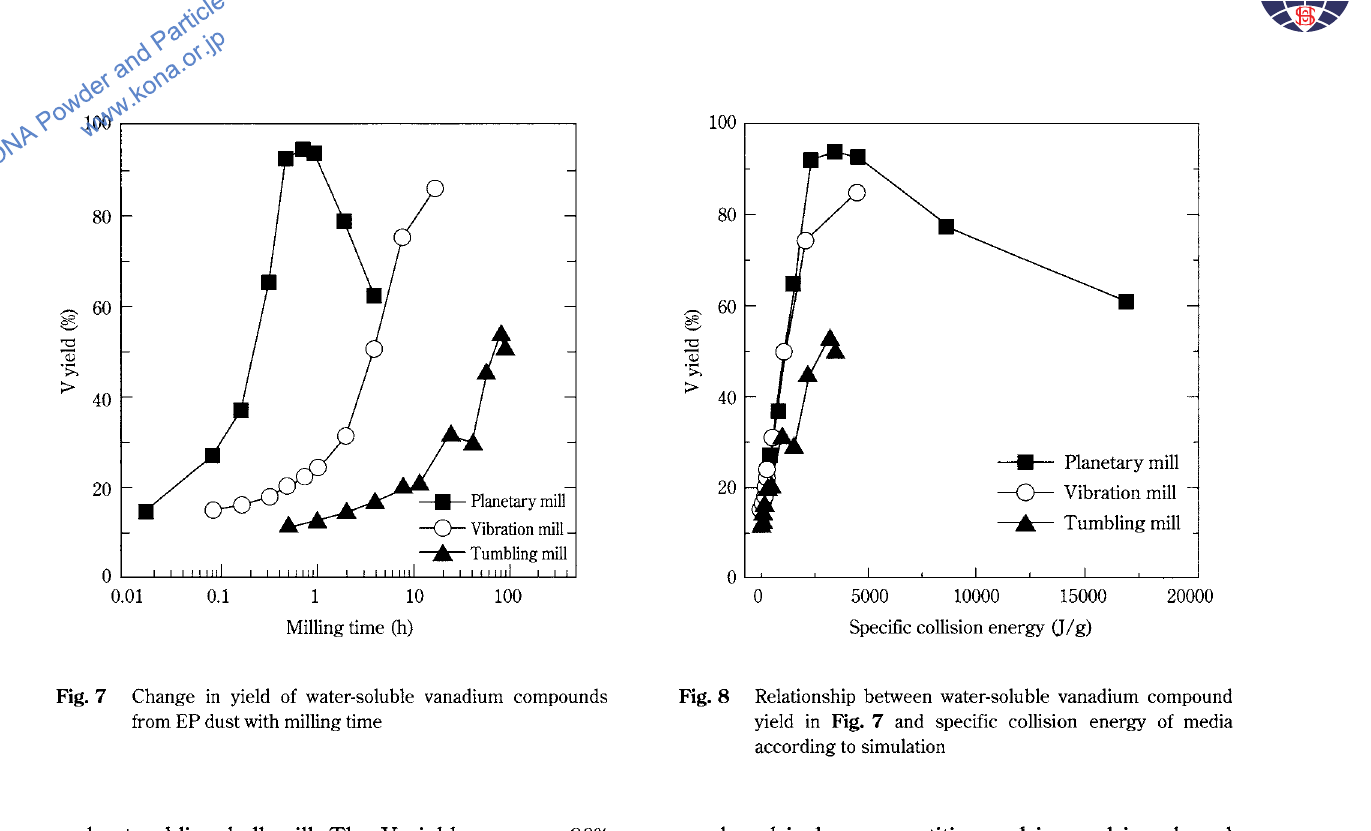
Relationship between water-soluble vanadium compound yield in Fig. 7 and specific collision energy of media according to